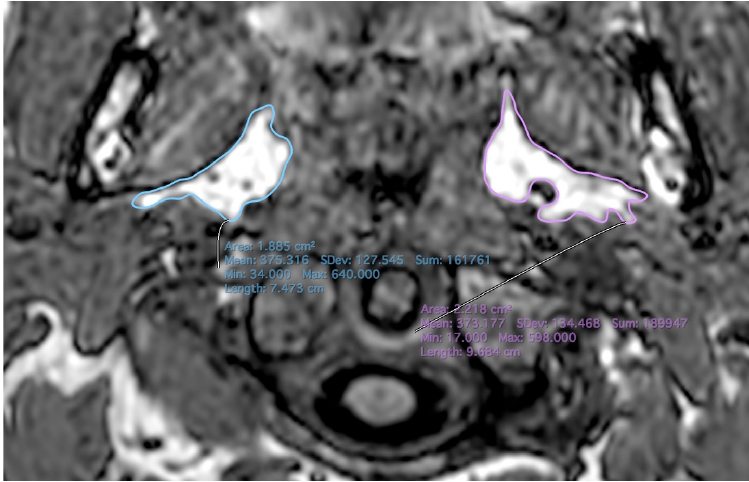
Figure 4. ( a ) Measurements of the uvula on T1 axial plane. Yellow: anteroposterior thickness, green: latero–lateral width, orange: area; ( b ) Measurements of the pharyngeal wall on T1 axial plane. Light green arrow on the left: internal carotid artery, dark green arrow on the right: parapharyngeal fat tissue, orange and blue: pharyngeal wall thickness from parapharyngeal fat, red and yellow: pharyngeal wall thickness from the internal carotid arteries.